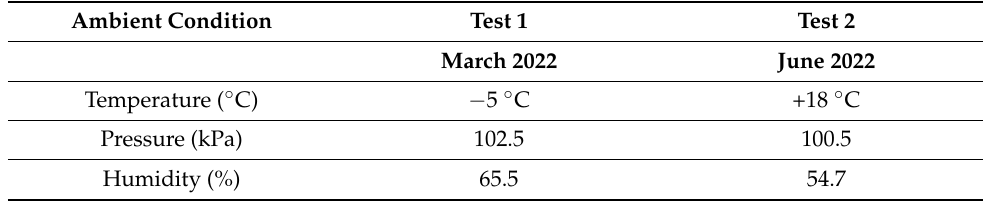
Table 5. Ambient conditions during the